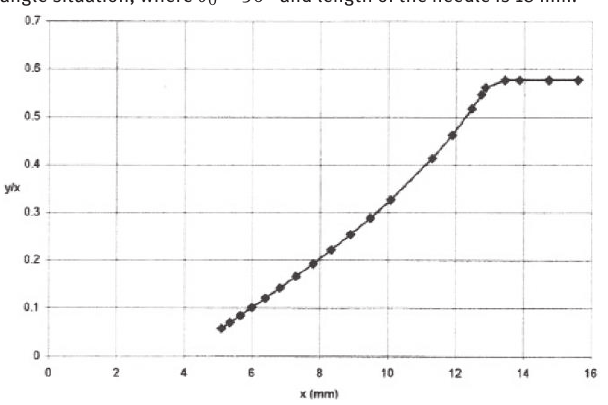
Figure 6B: The gradient of the needle during the VP action for motion corresponding to Fig. 6A.